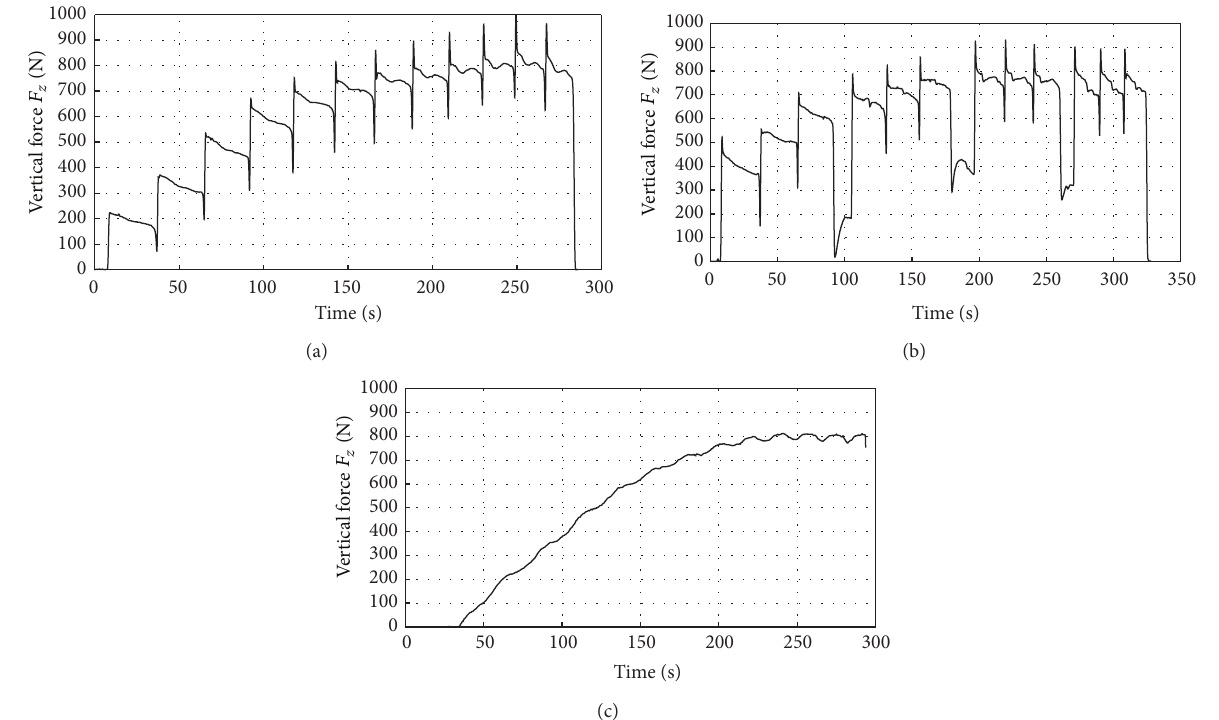
Figure 8: The vertical force ( 𝐹 𝑧 ) variation for the specified three different